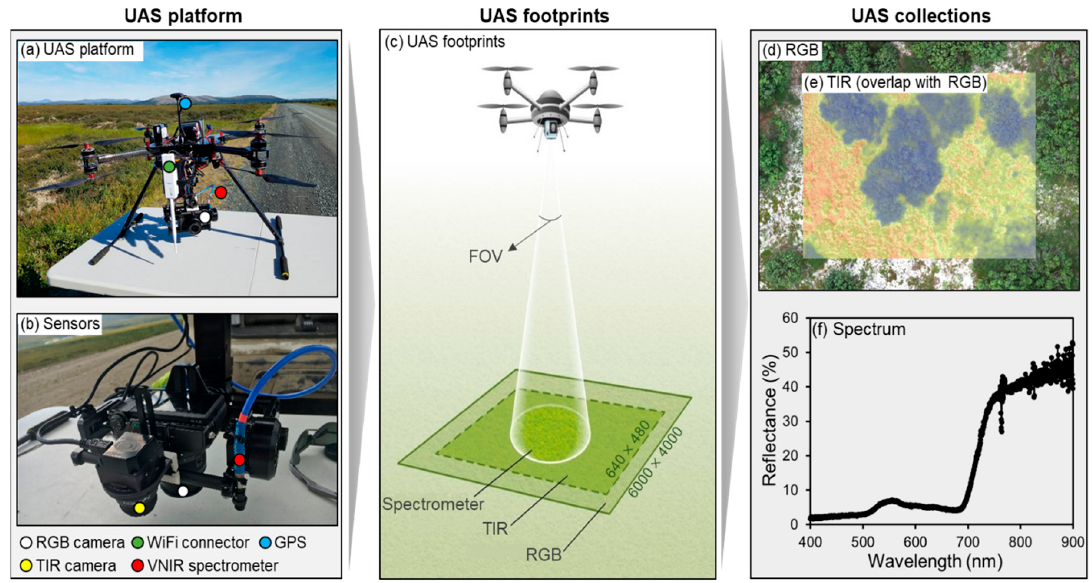
Figure 1. Osprey unoccupied aerial systems (UAS) airframe, sensor suite, sensor footprints, and example data. In ( a ) and ( b ), the white, yellow, and red dots, respectively, indicate the three types of sensors applied on the Osprey , i.e., Canon EOS M6 camera, ICI 9640 P-series thermal camera, and Ocean Optics FLAME spectrometer. The green dot indicates the WiFi connector, which enables real-time data logging from the Osprey . The light blue dot is the onboard global positioning system (GPS). The field of view (FOV) of the down-facing FLAME spectrometer, and the resulting image size from a Canon camera and ICI camera are shown in ( c ). An example of the optical RGB photo and thermal photo (overlapped with RGB) are shown in ( d ), and ( f ) is an example spectral reflectance data from the FLAME spectrometer.